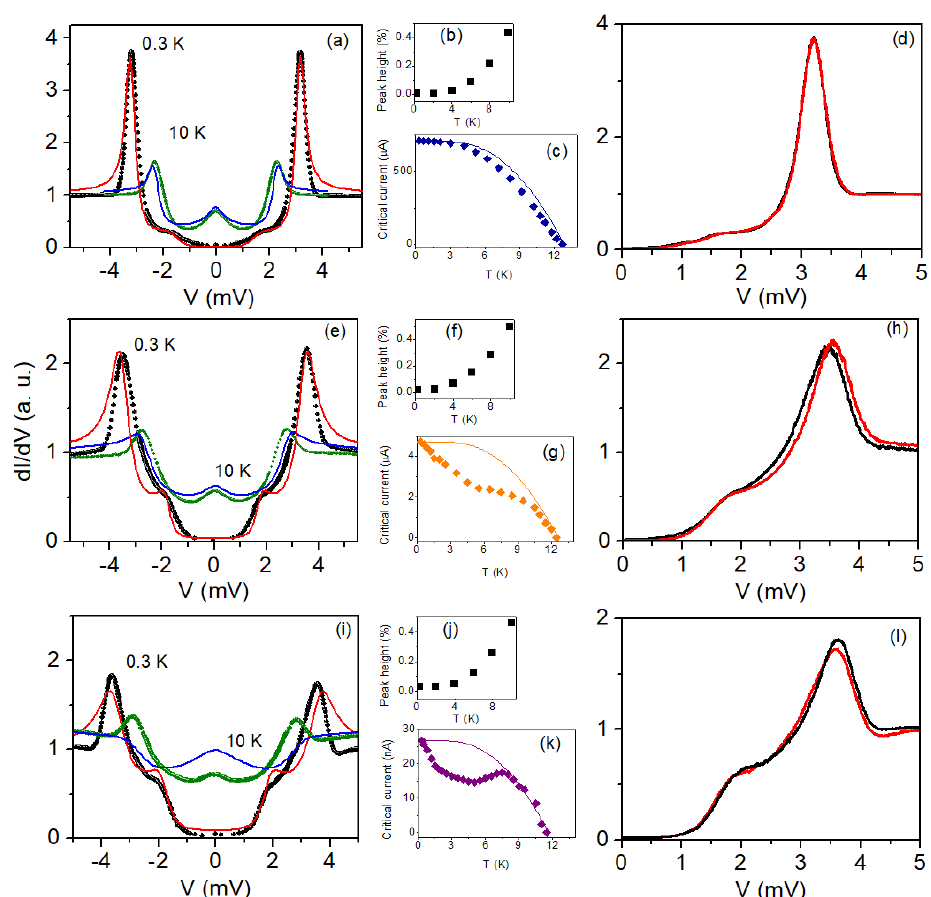
20% (a), P 97% (e) and P 99% (i) at 0.3 K ≤ ≈ ≈